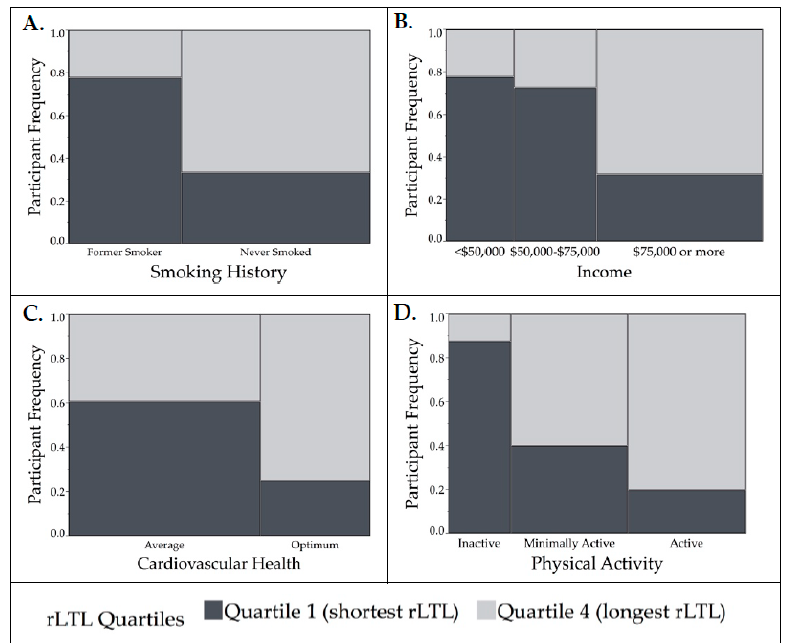
Figure 1. Mosaic plots demonstrating the relationship between significant covariates and relative leukocyte telomere length (rLTL) (Quartile 1 (shortest rLTL) and Quartile 4 (longest rLTL)) analyzed using Fisher’s exact test. Height of bars represents proportion of participants in each category and their quartile of rLTL, the width of each bar is proportional to sample size. ( A ) For smoking history ( n = 48), more participants that had never smoked had longer rLTL compared to former smokers ( p = 0.01). ( B ) For income ( n = 42), participants that had earned ≥ $75,000 had the longest rLTL ( p = 0.02). ( C ) Cardiovascular health measured by Life’s Simple 7 metric ( n = 44) was associated with rLTL; more participants with “optimal” cardiovascular health had longer rLTL than those with “average” cardiovascular health ( p = 0.02). ( D ) Physical activity was measured using the International Physical Activity Questionnaire ( n = 38). More participants that were active and had longer rLTL than those who were inactive ( p = 0.01).